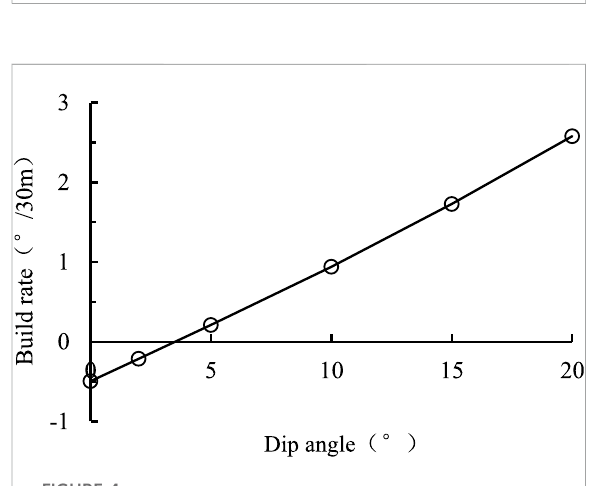
FIGURE 5 Pendulum BHA build rates at different formation anisotropy factor.